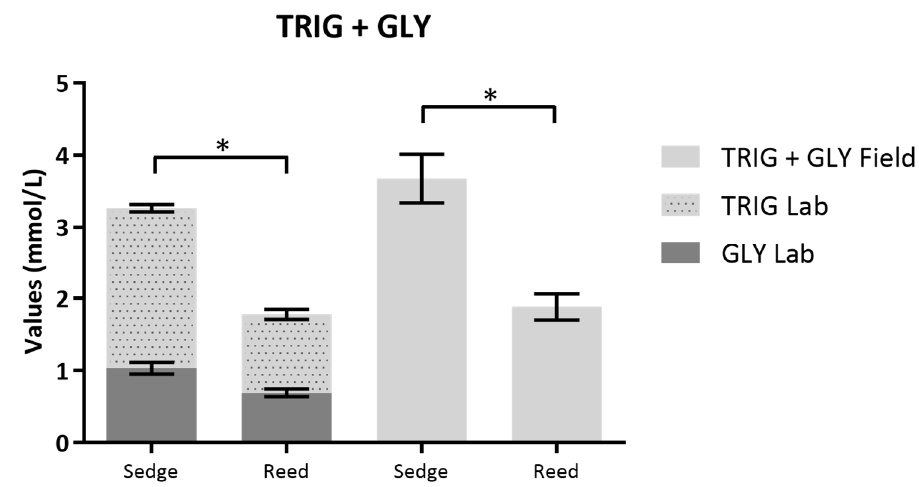
Figure 2. Triglycerides (TRIG) + Glycerol (GLY) (mmol/L) concentration (mean ± SE) for laboratorial analyses and TRIG + GLY (mmol/L) for field results of Sedge and Eurasian Reed Warblers captured during post-flight fasting (with tape lure). Field results were converted from mg/dL to mmol/L (1 mM—88.825 mg/dL of TRIG; 1 mM—88.652 mg/dL of GLY). Significance codes: *** = P < 0.001; ** P < 0.01; * P < 0.05.